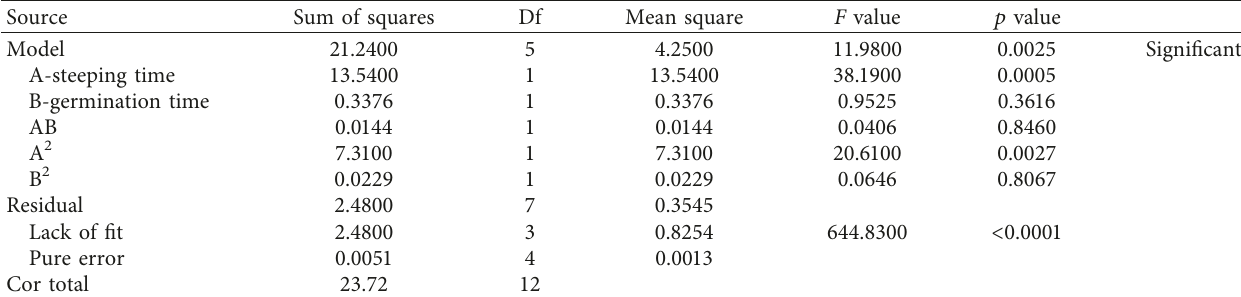
Table 6: ANOVA results for quadratic modelling of Brix content during quinoa malting.